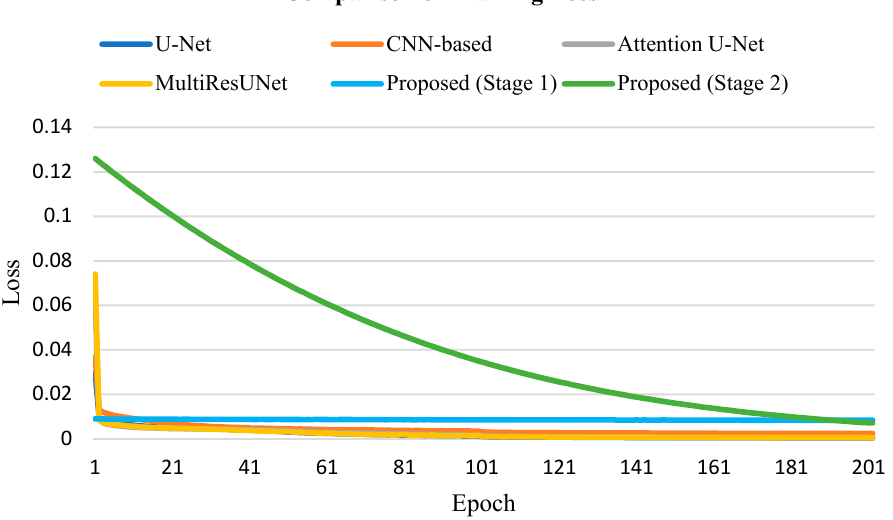
Figure 6. Comparison of training loss among different models.